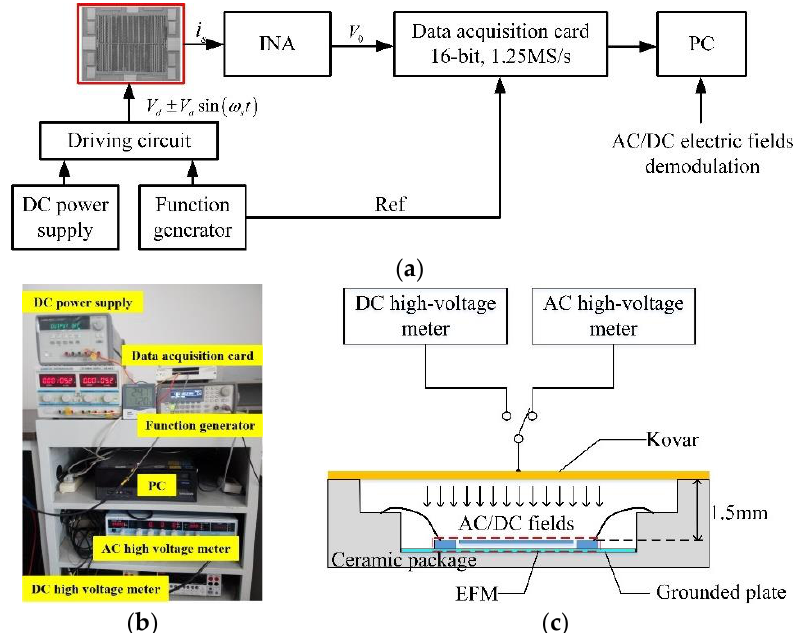
Figure 10. Verification test system for the AC/DC electric fields demodulation methods: ( a ) The schematic diagram; ( b ) The test setup; ( c ) A cross-section of the packaged EFM.